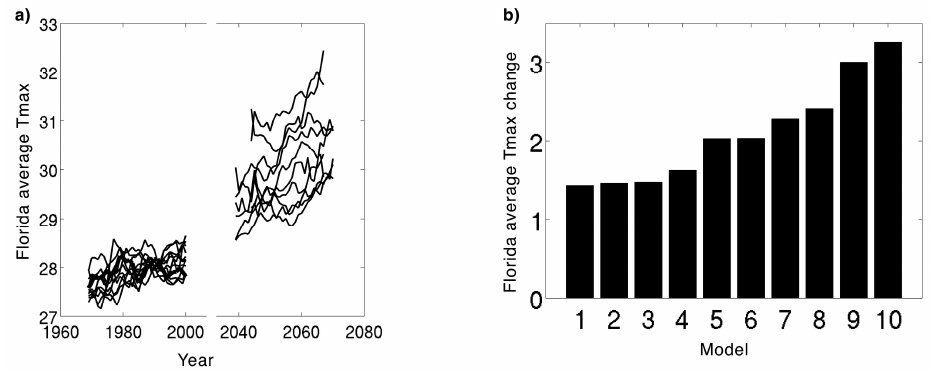
Figure 3. Comparison of historical simulations and future projections from the 10 downscaled models used in the Florida case studies (see Table 1): ( a ) 5-year running mean of Florida’s average annual maximum surface air temperature (T max in °C) from observations for 1969–2000 (thick black line) and from the 10 downscaled model simulations for the historical (1969–2000) and future (2039–2070) projection periods; ( b ) projected change, arranged from least to greatest, in Florida’s average annual T max (°C) from (1969–2000) to (2039–2070).